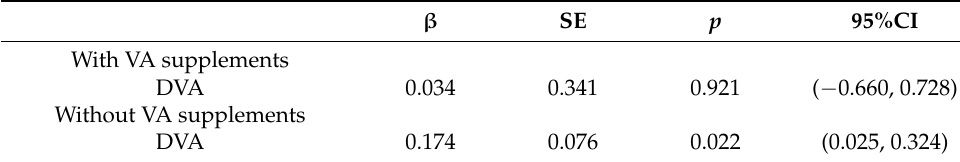
Table 4. Stratified analyses regarding the association of DVA and SVA with BMVA. β SE p 95%CI With VA